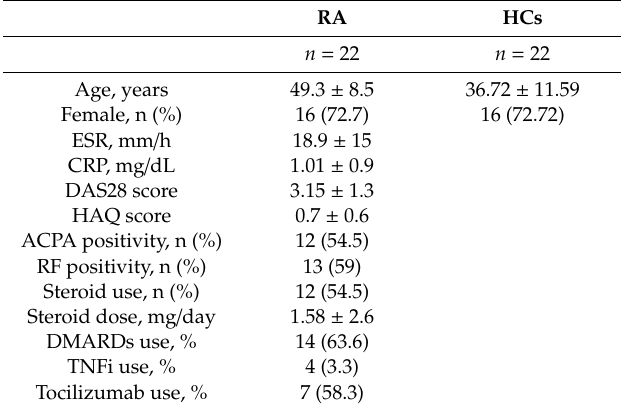
Table 2. Demographic and clinical characteristics of RA patients and